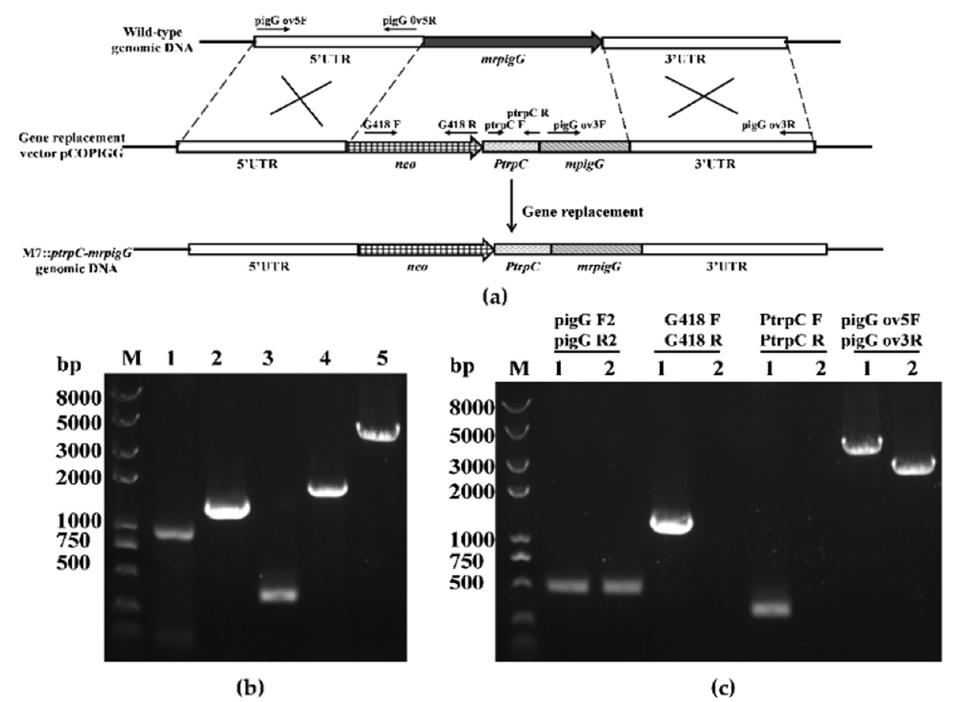
Figure 3. Overexpression of mrpigG in M. ruber M7. ( a ) Schematic representation of the homologous recombination strategy yielding mrpigG overexpression strains. ( b ) Construction of mrpigG overexpression construct by double-joint PCR. Lane 1, 5 ′ flanking region of mrpigG ; lane 2, G418 resistance cassette; lane 3, the trpC promoter; lane 4, mrpigG ORF regions plus 3 ′ flanking region of mrpigG ; lane 5, double-joint PCR product. ( c ) Confirmation of mrpigG homologous recombination events. Three primer pairs were used, and PCR amplifications showed distinct bands in different strains. Lane 1, the M7:: PtrpC-mrpigG strain; lane 2, the wild-type strain.